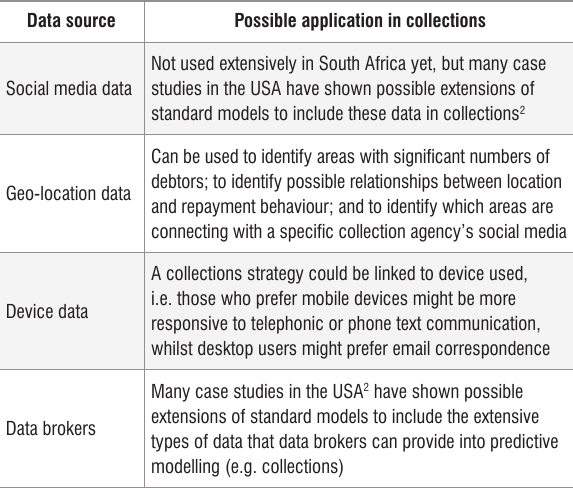
Table 2: Innovative uses of data sources in collections Data